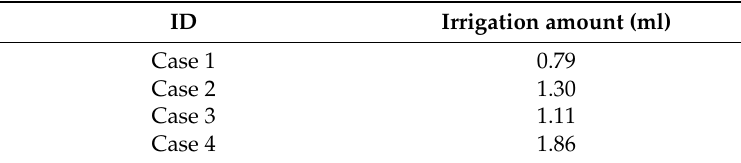
Table 11. Irrigation amount of each pot tray cell.